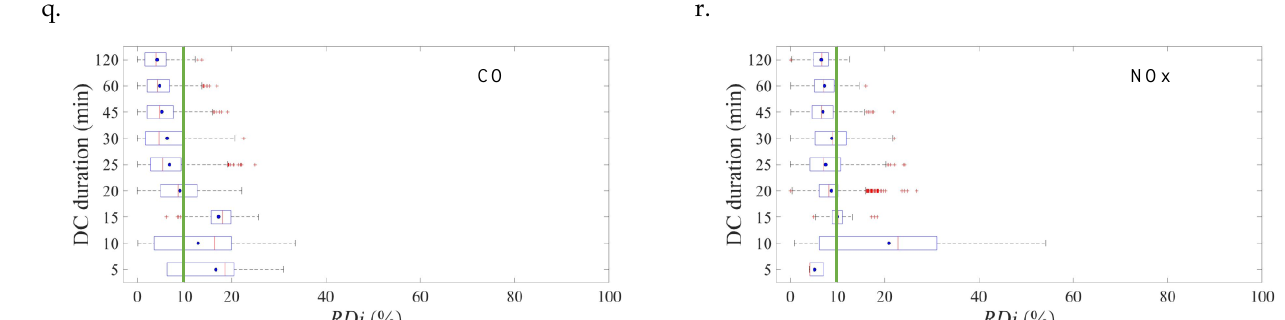
Figure 3. Box-plot of the RDi obtained in the Urban 1 region for the following characteristic parameters and emissions: ( a ) maximum speed, ( b ) standard deviation of speed, ( c ) average acceleration, ( d ) maximum acceleration, ( e ) standard deviation of acceleration, ( f ) average deceleration, ( g ) maximum deceleration, ( h ) standard deviation of deceleration, ( i ) percentage of acceleration, ( j ) percentage of deceleration, ( k ) percentage of cruising time, ( l ) positive kinetic energy, ( m ) root mean square of acceleration, ( n ) accelerations per kilometer, ( o ) kinetic energy, ( p ) emission index of CO 2 , ( q ) emission index of CO, ( r ) emission index of NOx. Boxes indicate interquartile ranges, and red + signs indicate outlier data. Blue dots inside the boxes indicate the average value, while vertical red lines indicate the median values. The vertical green lines indicate threshold values for acceptable representativeness.